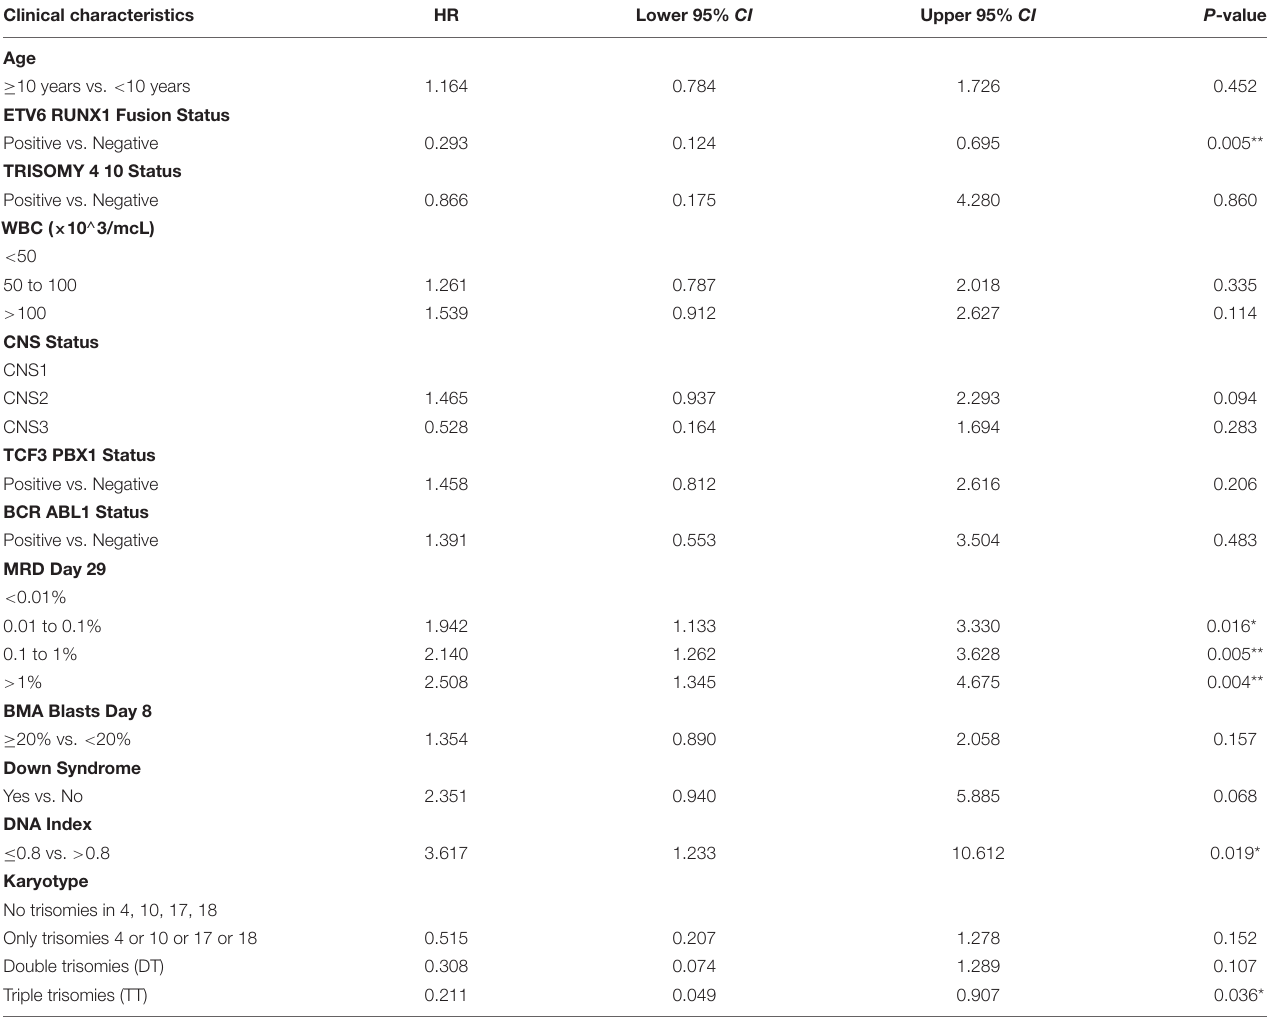
TABLE 3 | The results of multivariate Cox analysis. Clinical